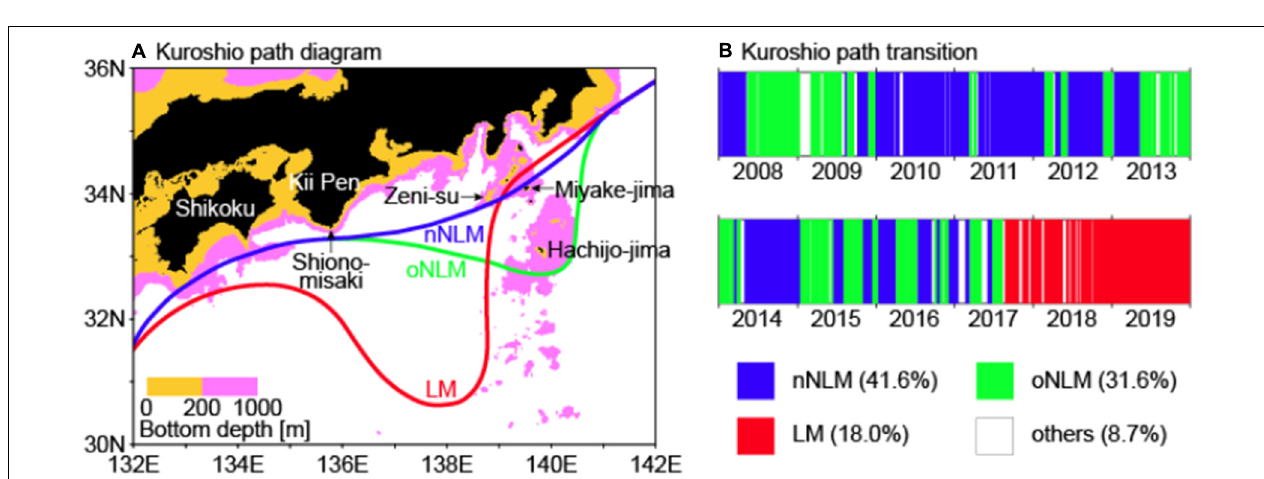
FIGURE 1 | Bottom topography of the ocean reanalysis product around Japan (A) and around the Tokai district (B) . Yellow line in (A) indicates the boundary of (B) . Yellow line in (B) indicates Suruga Bay as defined in this study.